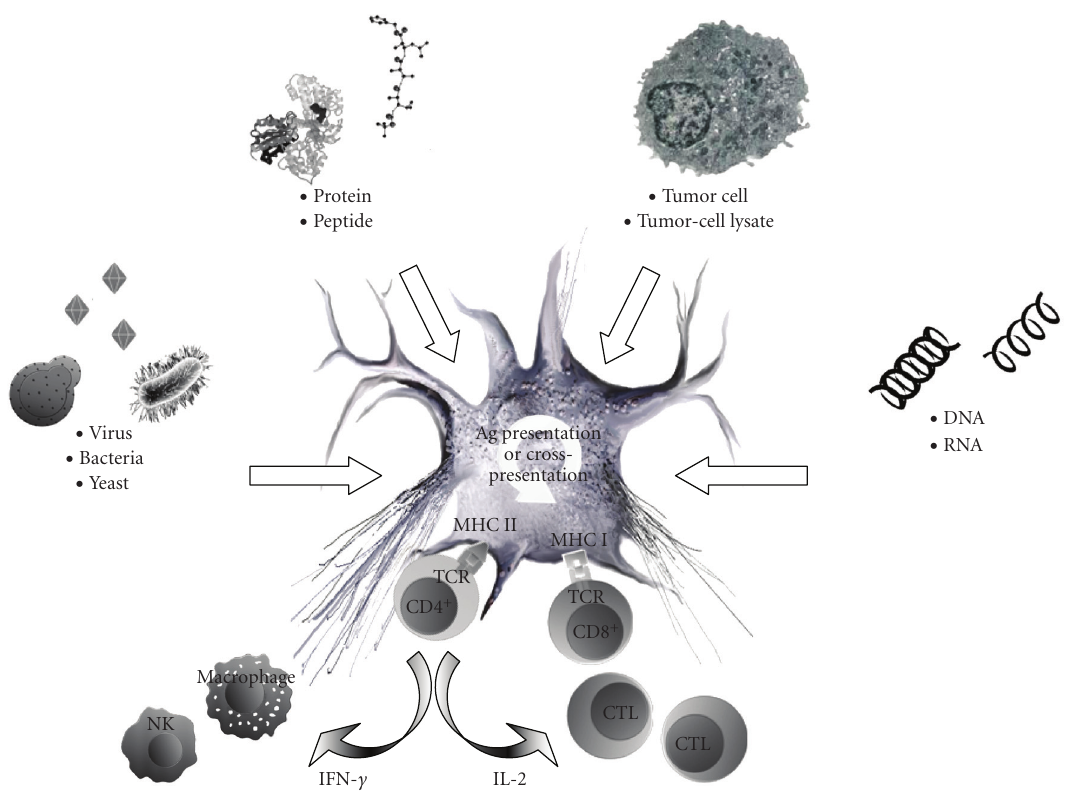
Figure 1: Various modalities employing dendritic cells for the development of therapeutic cancer